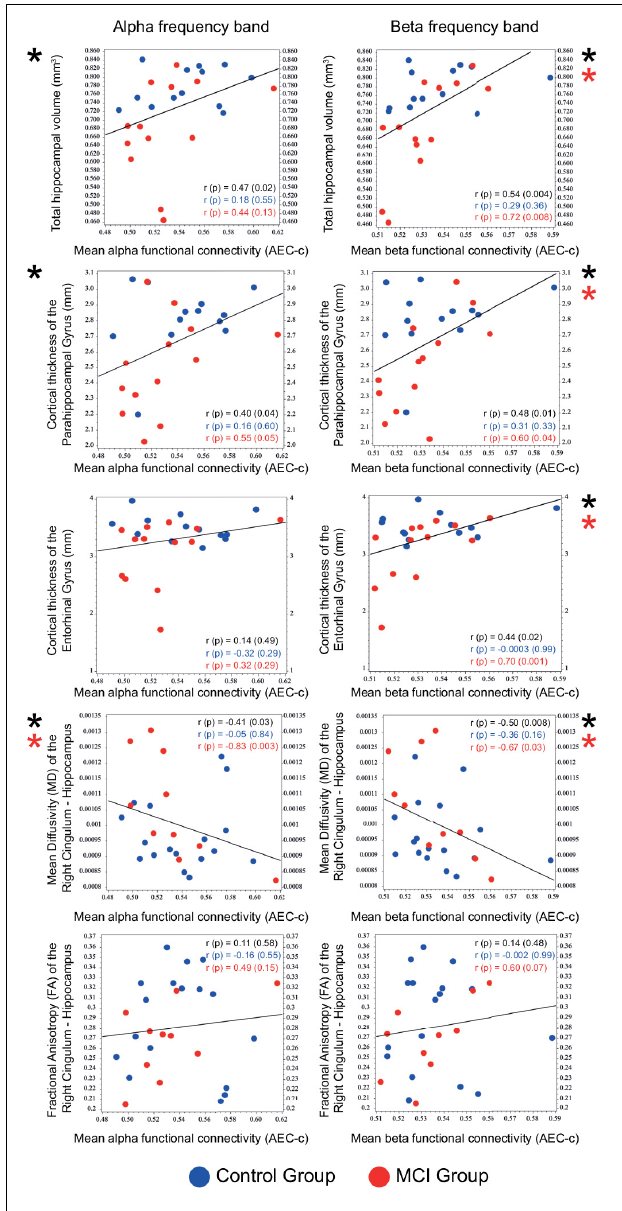
FIGURE 5 | Correlation of mean functional connectivity (AEC-c) in the alpha and beta band with the size ( n = 26) and DTI measures ( n = 27) of medial temporal lobe structures. Spearman r and p -values are reported for the total sample (black) and for the two study groups (Control group: blue, MCI group: red). Significant correlations are marked with an